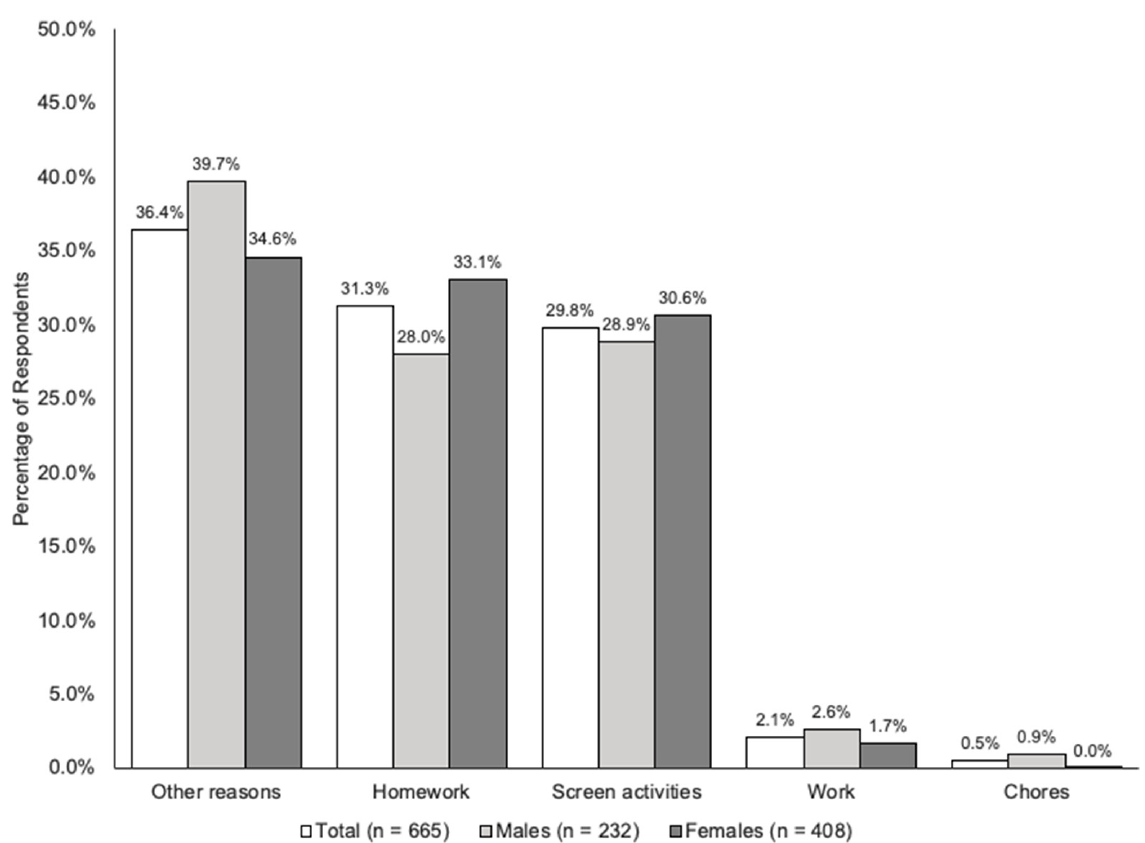
Figure 1. Main reasons for not getting sufficient hours of sleep.